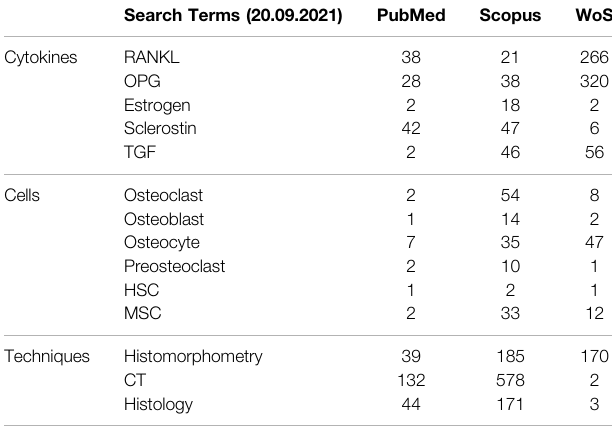
TABLE 2 | Search terms and number of resultant quantitative reports on experimental measurements relating to parameters that have to date been used in agent-based models (micro-MPA models) of bone or bone cell population dynamics